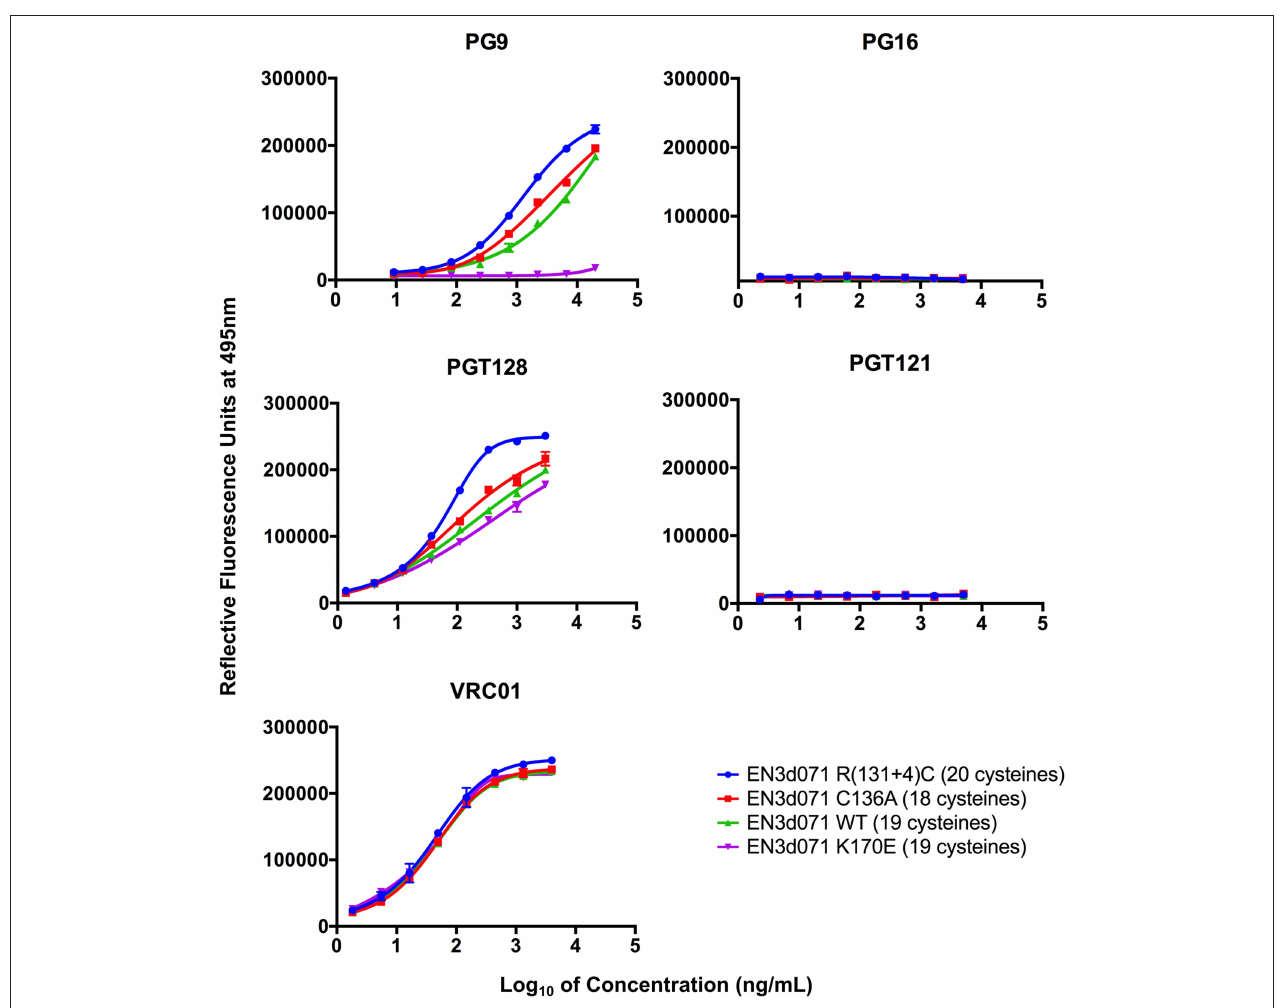
FIGURE 4 | bN-mAb binding to recombinant gp120 EN3d071 WT and mutants by fluorescent immunoassay. Recombinant gp120 sequences EN3d071 C136A (18 cysteines), EN3d071 WT (19 cysteines), EN3d071 R(134 + 1)C (20 cysteines), and EN3d071 K170E (19 cysteines) were produced with an N-terminal gD tag and captured onto microtiter plates with a mouse monoclonal anti-gD antibody. The captured proteins were then incubated with a panel of broadly neutralizing monoclonal antibodies that included PG9, PG121, PGT128, and VRC01. After washing, the wells were incubated with Alexa Fluor 488 labeled goat anti-human IgG (ThermoFisher Scientific, Waltham, MA) and washed as described in Materials and